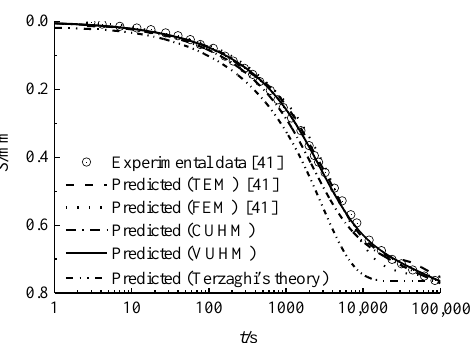
Figure 11. Comparison of prediction values and experimental results of the settlement theory under different models.